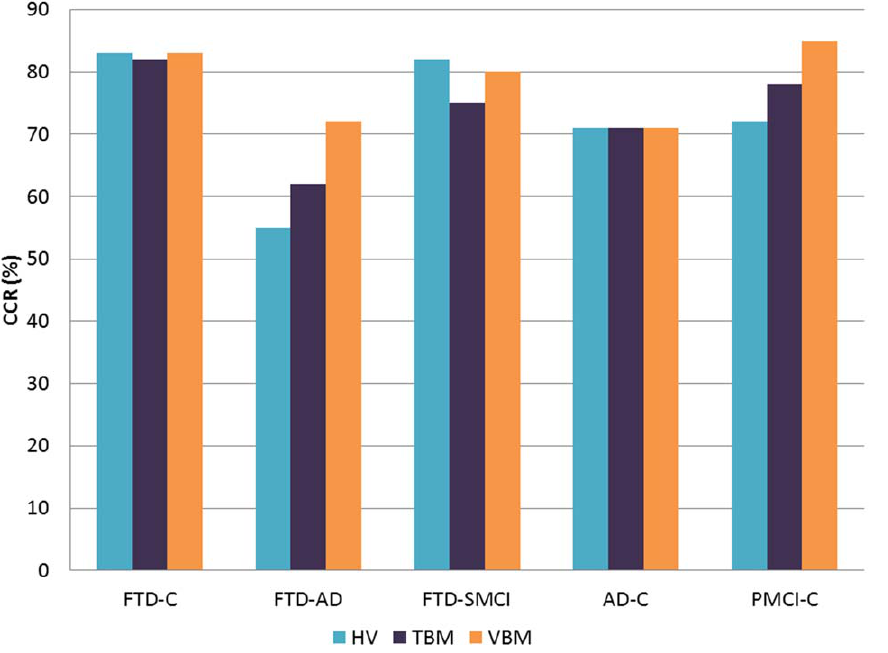
doi:10.1371/journal.pone.0052531.g002 isons obtained significant results in the same paired group comparisons as in non-normalized hippocampal volumes.